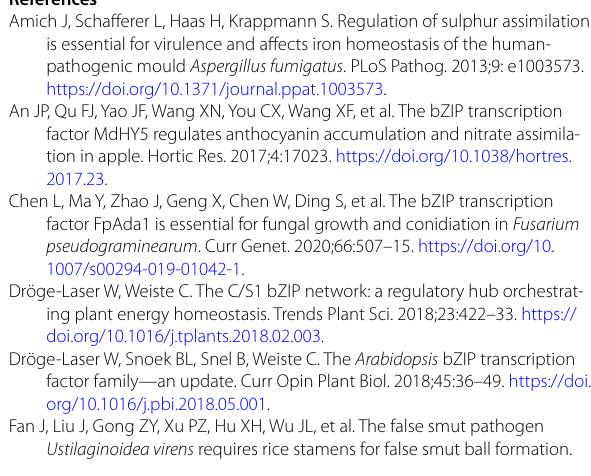
the verification. Figure S4. Detection of UvbZIP6 expression in UvbZIP6- knockout mutants and complemented strains by semiquantitative RT-PCR. The RNA samples were collected from mycelia cultured in PSB medium for 7 days. The fragments of β-tubulin were amplified as reference. Figure S5. Conidia germination rate of the tested strains. The conidia were spread on water agar (WA) or PSA plates. Figure S6. Microscopic observation of rice ovary after inoculation with JS60-2 or UvbZIP6- knockout mutants.